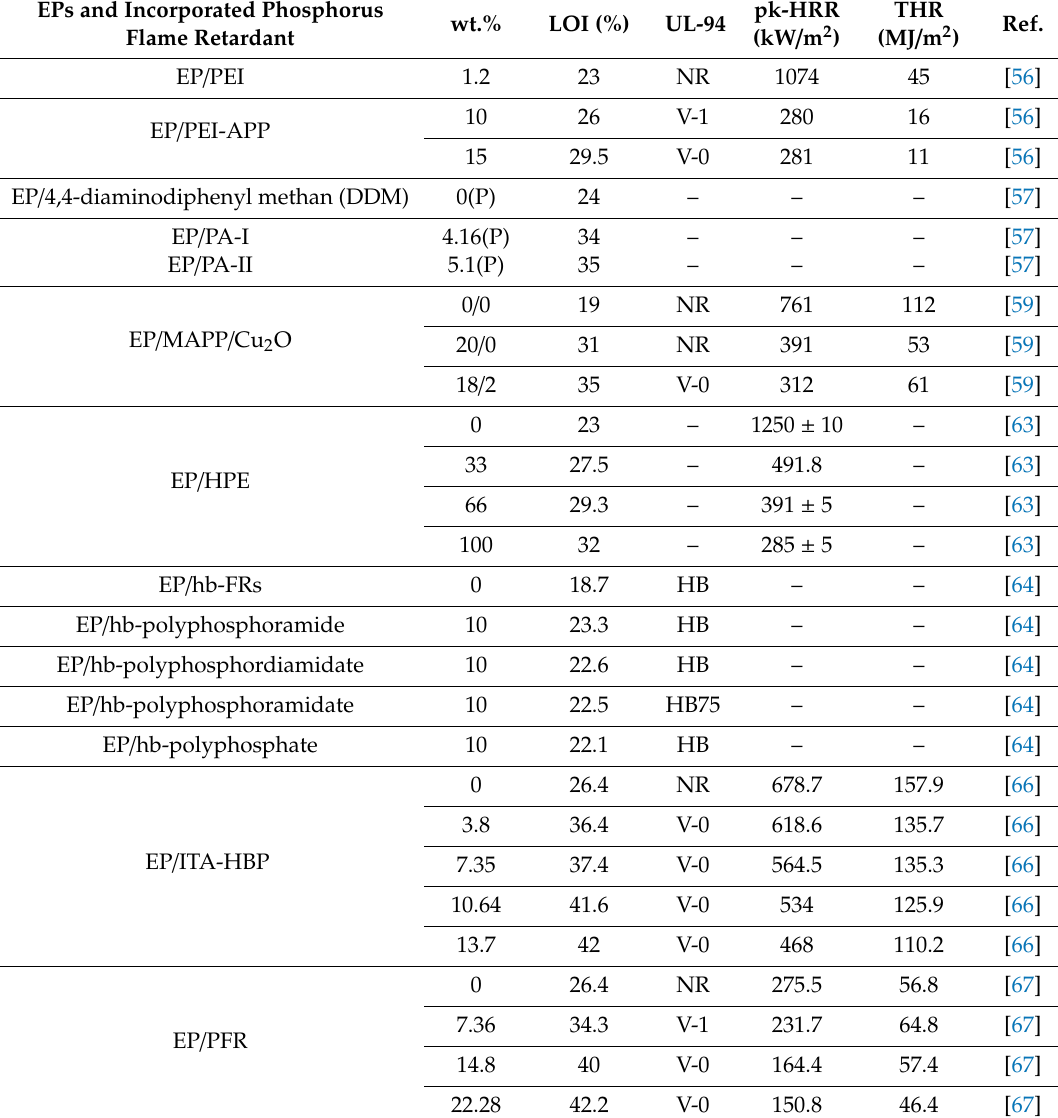
Table 2. The flame retardancy performance of epoxy containing phosphorus flame retardants. EPs and Incorporated Phosphorus wt.% LOI (%) UL-94 Flame Retardant EP / PEI